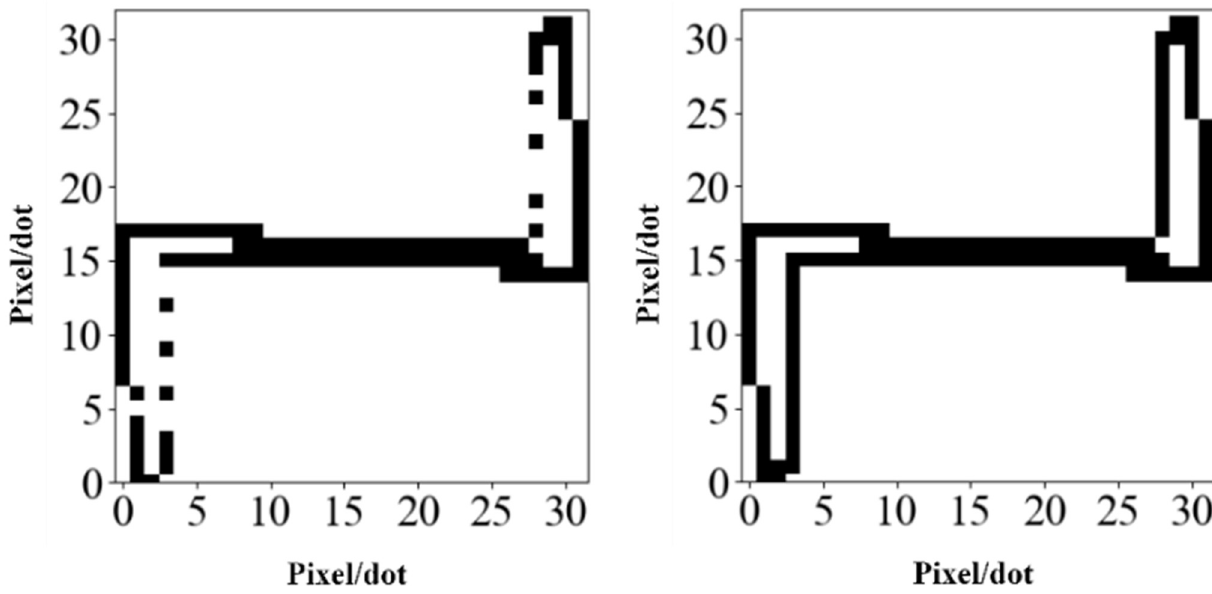
Fig 3. The binary V- I trajectory mapping for a fluorescent lamp( N = 32). (a) Linear interpolation. (b) Bilinear interpolation.